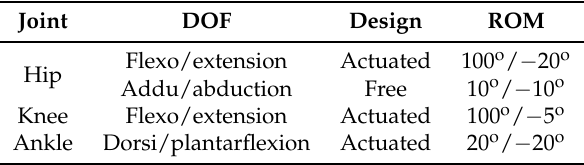
Table 1. Actuated degrees of freedom (DoF) and range of motion (ROM) of H1 exoskeleton joints. Sign criteria: positive for flexion (dorsiflexion for ankle) and negative for extension (plantarflexion for